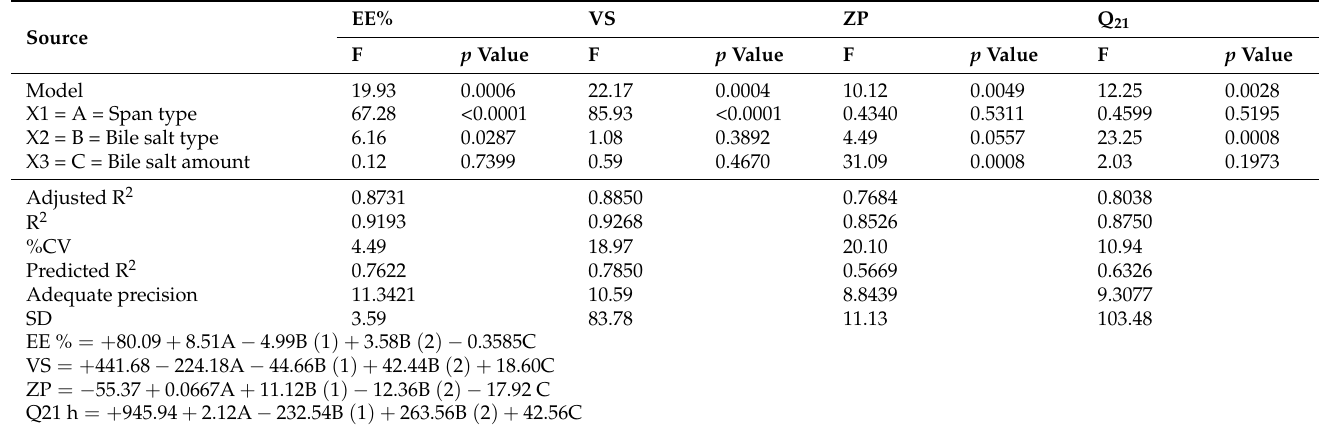
Table 1. Analysis of variance of the measured responses